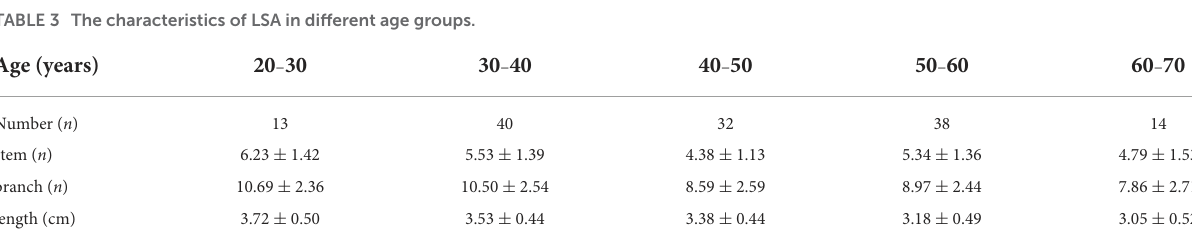
TABLE 3 The characteristics of LSA in different age